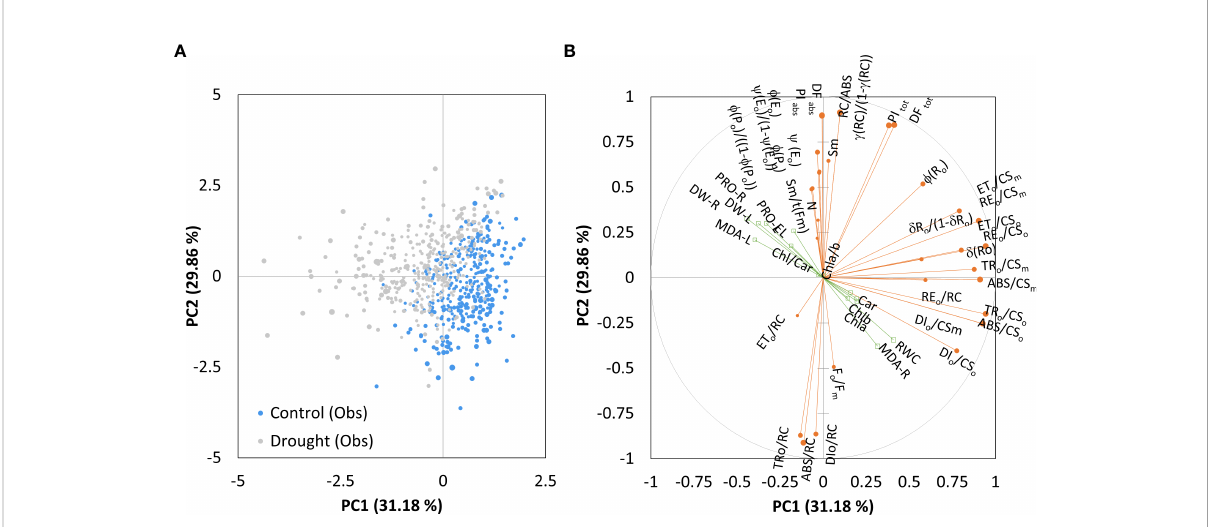
FIGURE 4 Ordination of all observations (A) and correlation between variables on the fi rst two main components (B) obtained by principal component analysis on measured parameters (chlorophyll a fl uorescence as active variables and biochemical measurements as supplementary variables) for control and PEG-induced drought treatment of 18 winter wheat cultivars (n =